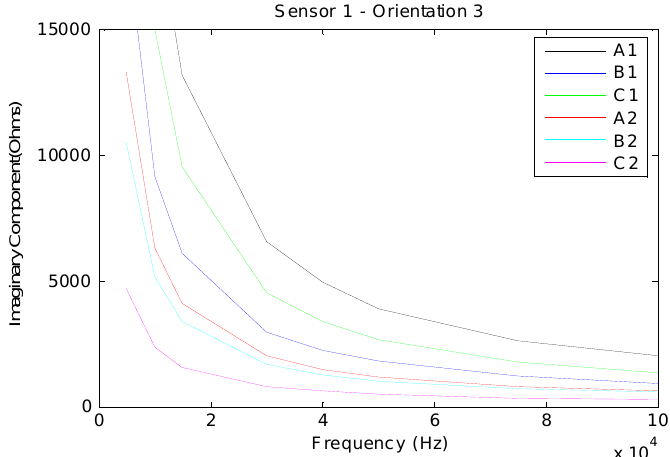
Figure 38. Sensor 1 characteristics for pork belly samples at orientation 3.